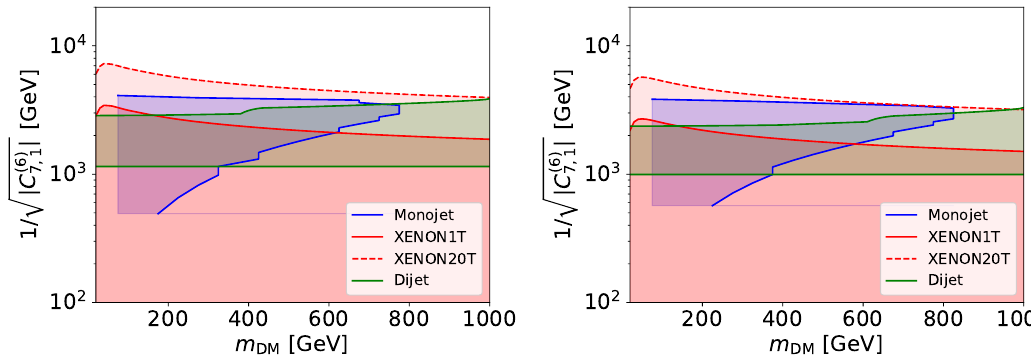
Figure 3. Exclusion limits for axial mediator couplings to DM from XENON experiment for 1 ton × year exposure (red solid) and for 20 ton × year exposure (red dashed), from LHC monojet (blue) and dijet (green) analyses with 139 fb − 1 integrated luminosity. The results are shown in the plane with the DM mass on the x axis and inverse of the square root of the Wilson coefficient | C (6) the y axis for the BM1 (left) and BM2